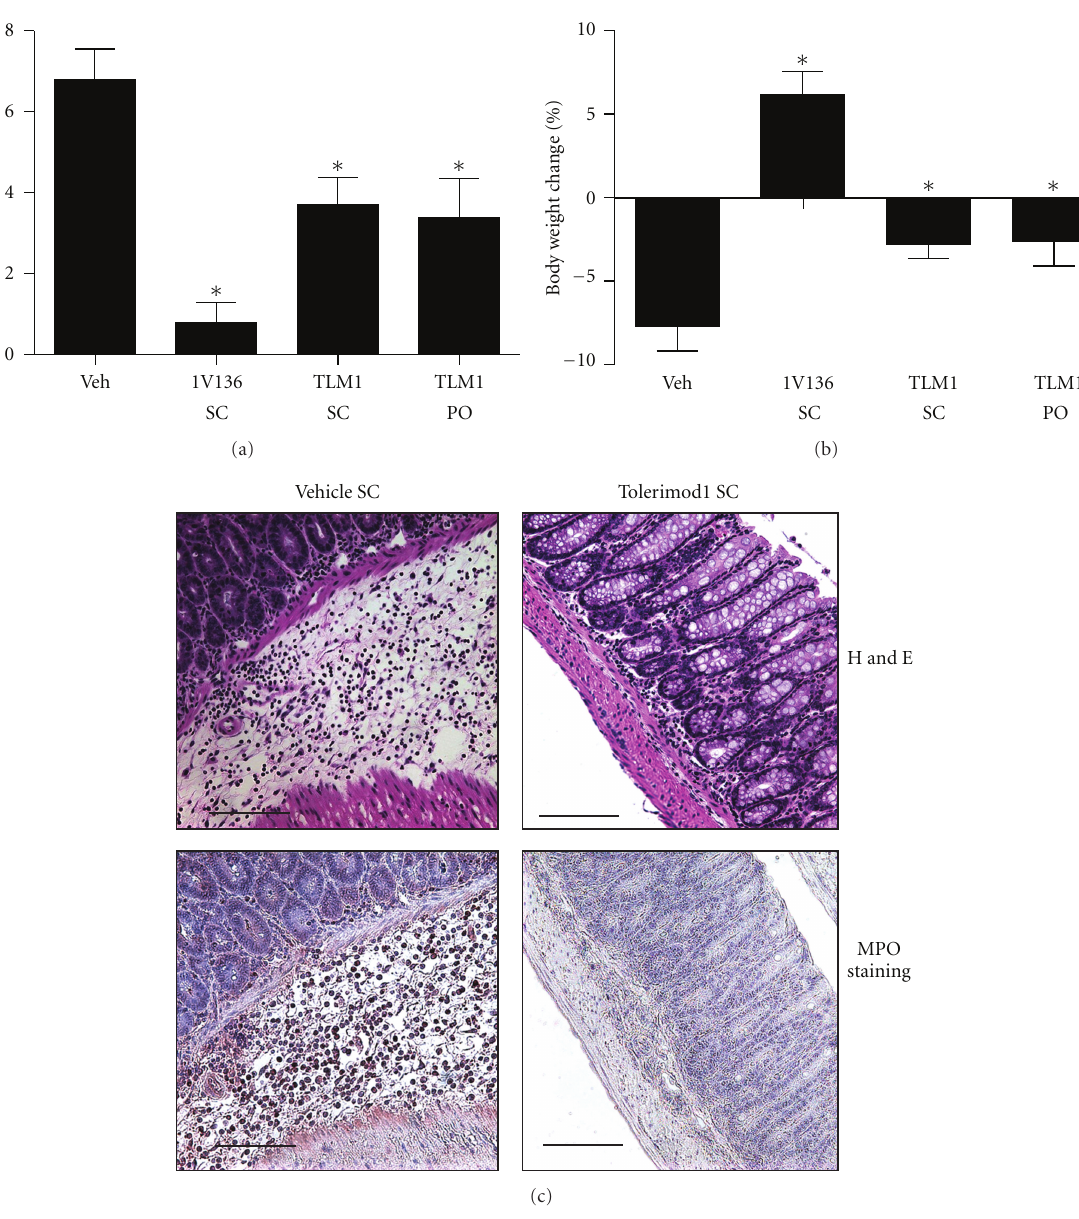
Figure 5: Tolerimod1 reduced the severity of DSS-induced colitis (a and b) DSS-colitis mice ( n = 12 per group) were treated with 200 nmol Tolerimod1 subcutaneously (SC) or orally (PO) for 7 days. Disease activity index (a) and body weight loss (b) were evaluated. (c) The colons isolated from mice treated s.c. with vehicle or Tolerimod1 were stained with hematoxylin or eosin, or immunostained for MPO. Data shown are mean ± SEM and are pooled from 2 independent experiments that showed similar trends. ∗ Denotes P < 0 . 05 by one-way ANOVA with Dunnett’s post hoc testing compared to the vehicle-treated